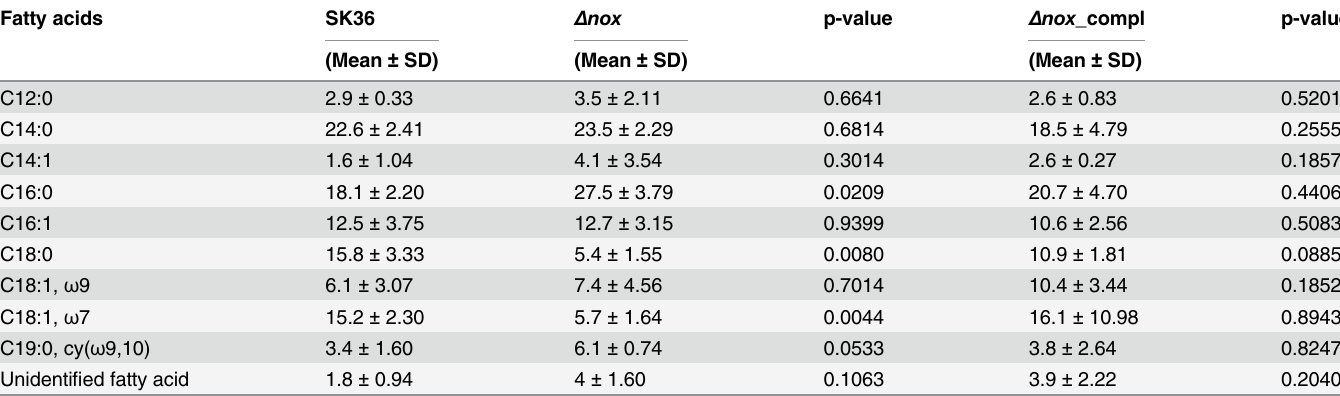
Table 2. Comparison of fatty acid composition in the nox mutant and wild-type. Fatty acids SK36 Δ nox